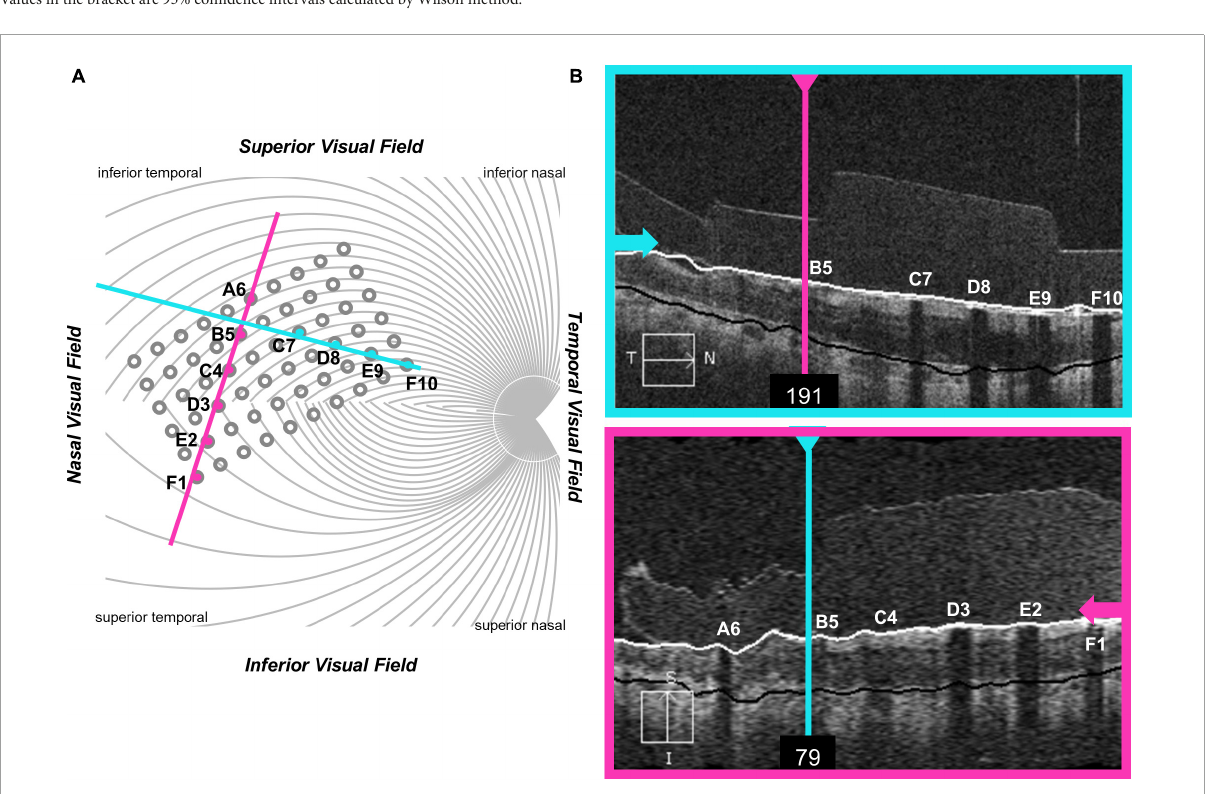
FIGURE3 OCT data from participant S1. (A) Schematic showing the estimated location of OCT b-scans overlaid on the array (alignment was carried out using the registered OCT fundus image). The array schematic is flipped along the y-axis to reflect visual space coordinates, such that the top of the schematic represents the superior visual field and the inferior retina. (B) The metal electrodes block light from the scanning light source, casting shadows on the retinal